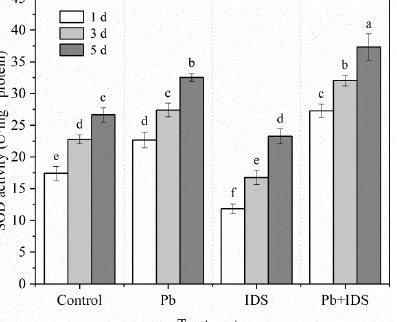
Figure 9. Effects of Pb, IDS, and Pb+IDS on SOD activities of maize seeds. Maize seeds treated with distilled water (control), Pb (20 mmol·dm −3 PbCl 2 ), IDS (100 mmol·dm −3 ), or Pb+IDS were used, and their SOD activities were measured 1, 3, and 5 d after sowing. Error bars represent the standard deviation of the mean ( n = 5). Means associated with different letters are significantly different among treatments and time points ( p < 0.05; Duncan’s new multiple range test). Pb, lead; IDS, iminodisuccinic acid; SOD, superoxide dismutase.